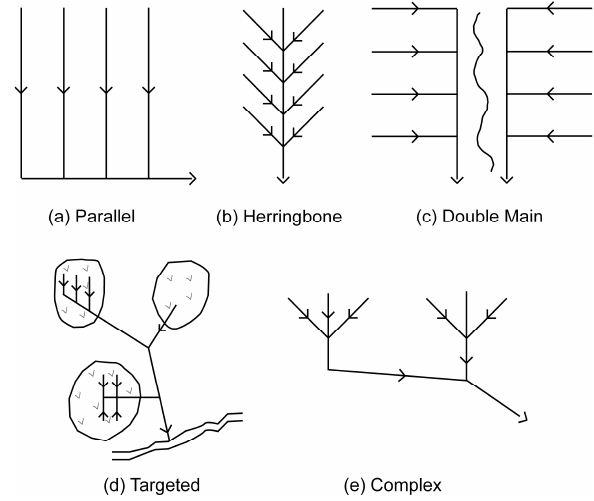
Figure 1. Commonly used subsurface drainage system patterns (modified from